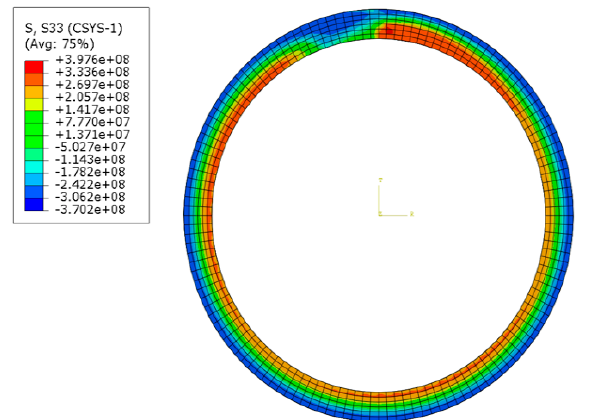
Figure 15. Axial and hoop residual stress distribution through pipe thickness ( z = 156 mm, α = 270°, Figure 2).